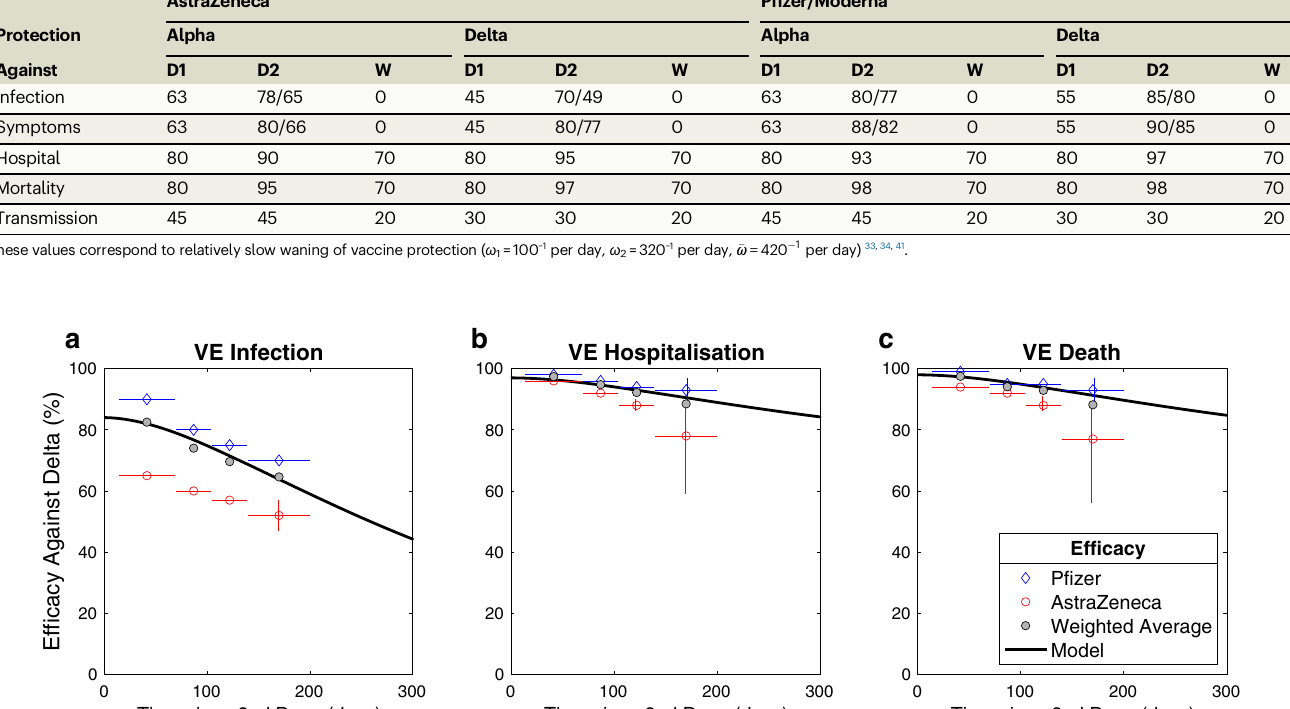
average (grey), the model obeys the simple compartmental rules described above. The points refer to mean estimated values, vertical lines represent the 95% con- fi dence intervals, capturing uncertainty in the data, while the horizontal lines cor- respond to the period over which the data is amalgamated.